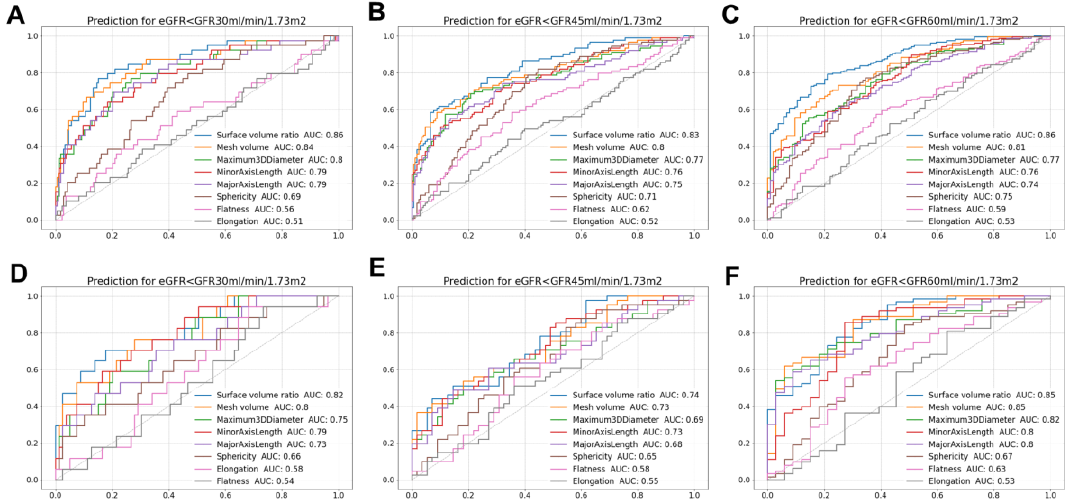
Figure 3. ROC curves of the morphological features for different eGFR thresholds. ROC curves in total participants for eGFR ( A ) <30 mL/min/1.73 m 2 , ( B ) <45 mL/min/1.73 m 2 , and ( C ) <60 mL/min/1.73 m 2 . ROC curves in participants with diabetes for eGFR ( D ) <30 mL/min/1.73 m 2 , ( E ) <45 mL/min/1.73 m 2 , and ( F ) <60 mL/min/1.73 m 2 .